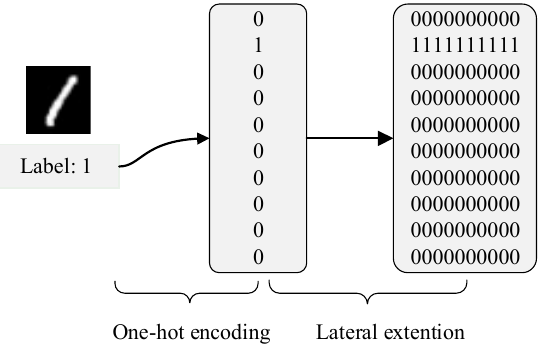
Figure 2. The MNIST classification computing framework based on DSNNs.